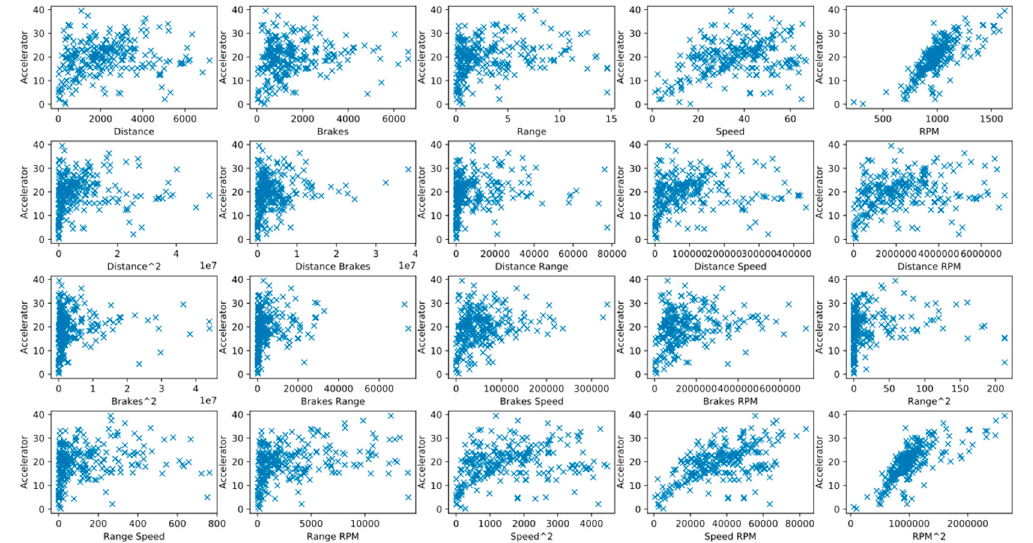
Figure 6. Relationship between “Accelerator” and its independent variables.